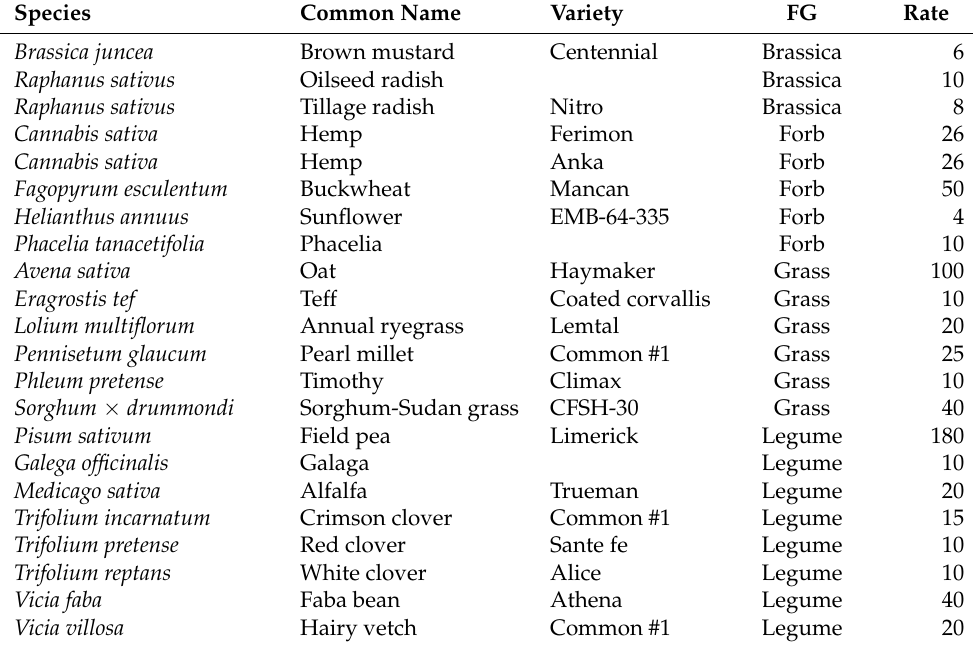
Table 1. List of all the crops used, their common names, variety, functional grouping (FG) and seeding rate in lbs ha − 1